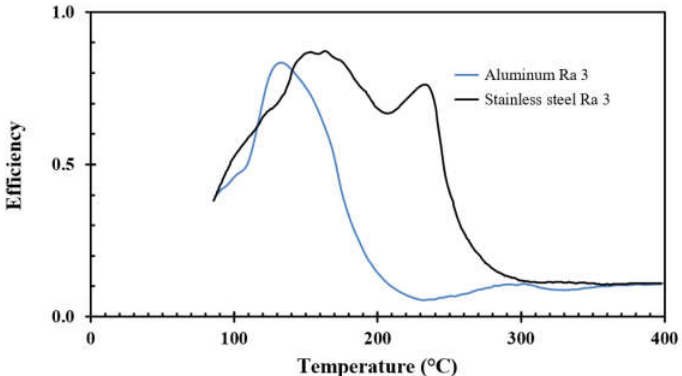
Figure 16. Average cooling efficiency for water droplets impinging onto the stainless steel and aluminum disc (marked on the figure) with a surface roughness of Ra 0.4.